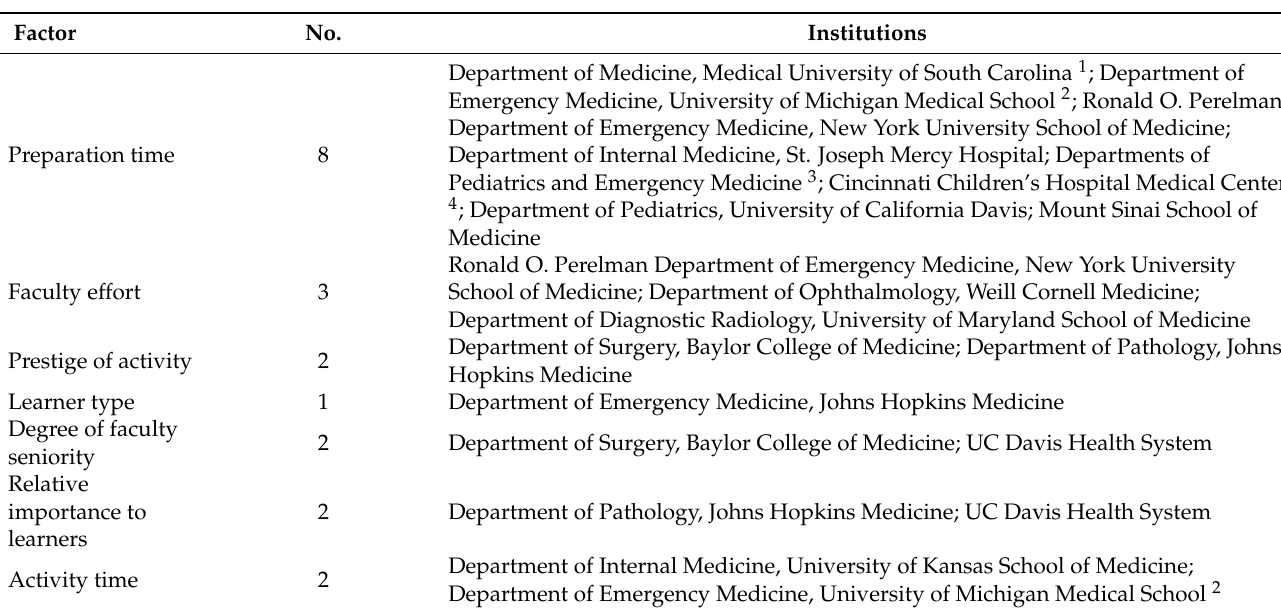
Table 1. Some Factors Contributing to EVU Calculations in Reporting U.S. Medical